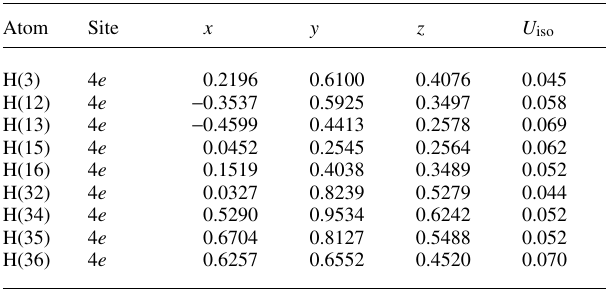
Table 2. Atomic coordinates and displacement parameters (in Å 2 )